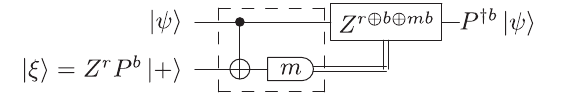
FIG. 4. Circuit to combine ancillary qubits Z r P a j jþi and Z s P b k jþi produces a new ancillary qubit Z q P a ⊕ b jþi . This way, Bob can generate any one of 2 2 N possible ancillary qubits whose phase takes the form of sums (modulo 2) of Alice ’ s Pauli keys a j and b k .